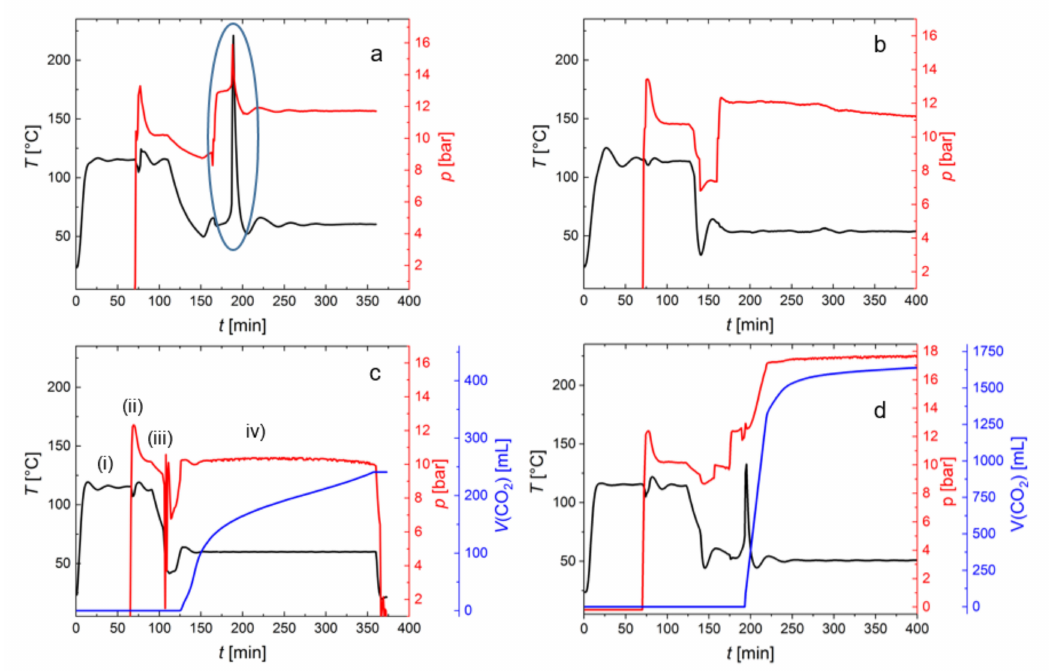
Figure 1. Reactor logs of batch experiments with 30 g of Caradol and 5 mg of catalyst ( a ) homopolymerization of PO, set T = 60 ◦ C (PPG_1) ( b ) homopolymerization of PO, T = 55 ◦ C (PPG_2) ( c ) copolymerization of PO with CO 2 , T = 60 ◦ C, p = 10 bar (PPEC), and ( d ) polymerization during which CO 2 was added at the onset of the exotherm (PPG /